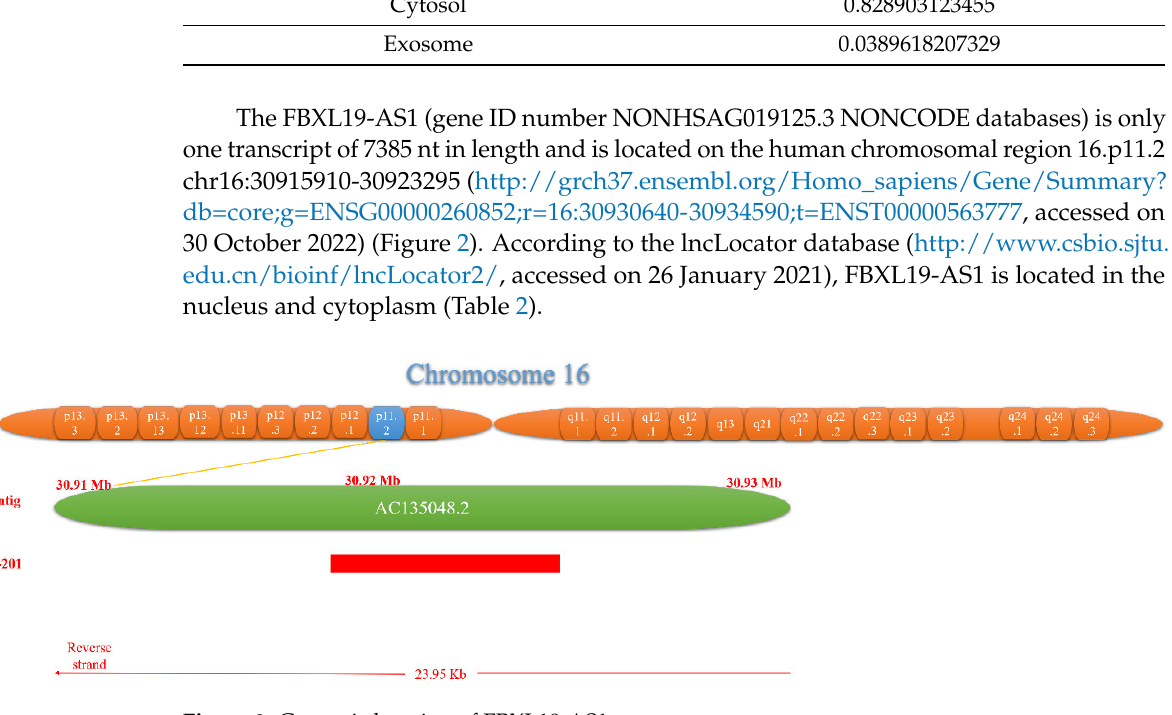
Figure 2. Genomic location of FBXL19-AS1. Table 2. Analysis of the subcellular localization of FBXL19-AS1 (from lnclocator database). Database